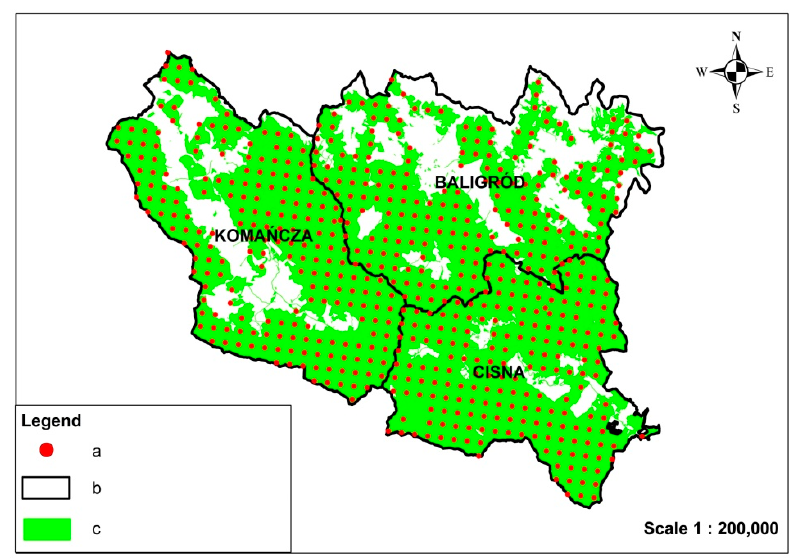
Figure 1. Nodes of a 1 × 1 km grid extrapolated from the 4 × 4 km grid of the National Forest Inventory: ( a ) centers of sample plots, ( b ) boundaries of Forest Districts, and ( c ) land belonging to State Forests Holding.